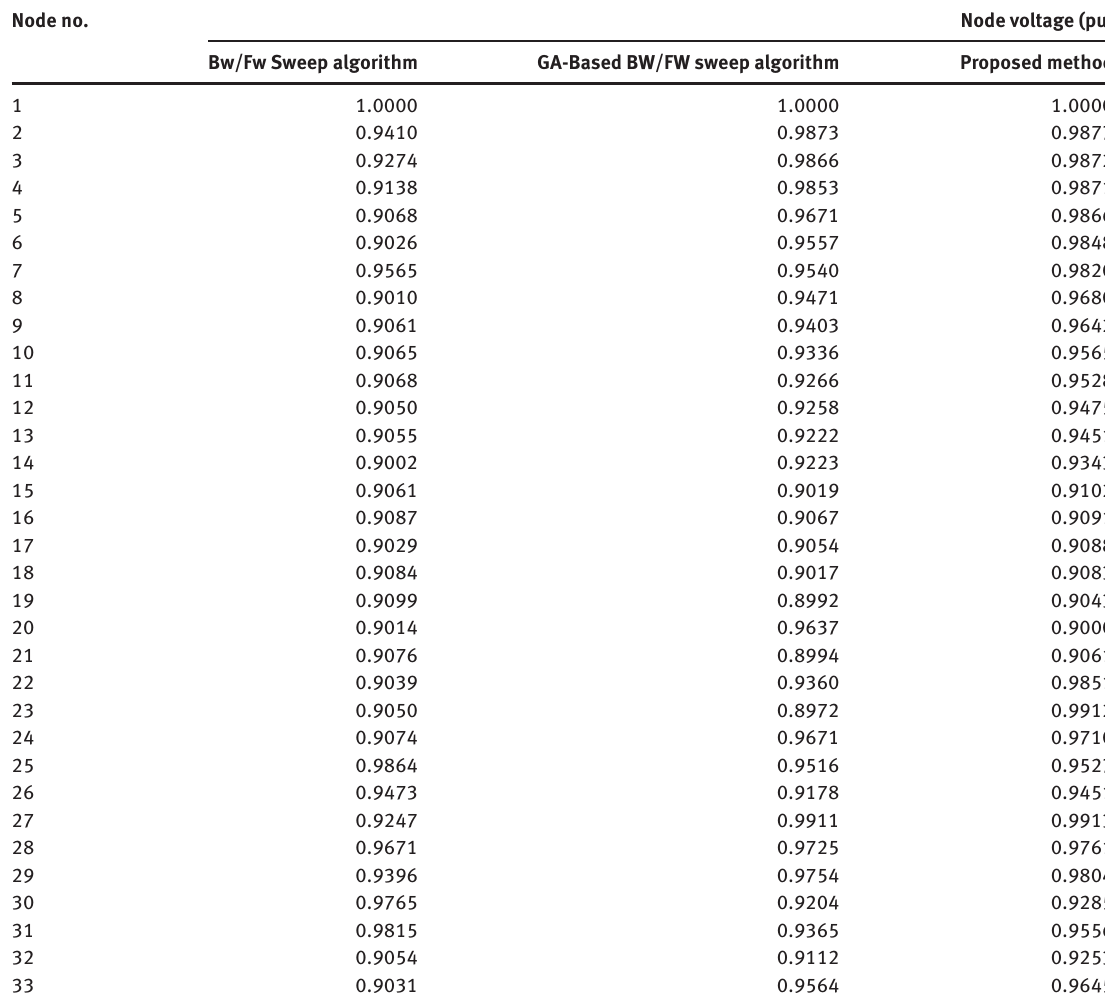
Table 1: Node Voltages of the Distribution System by Using the Proposed and Existing Methods. Node